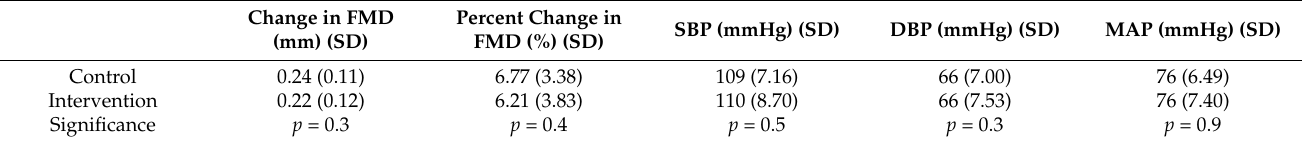
Table 4. Primary and Secondary